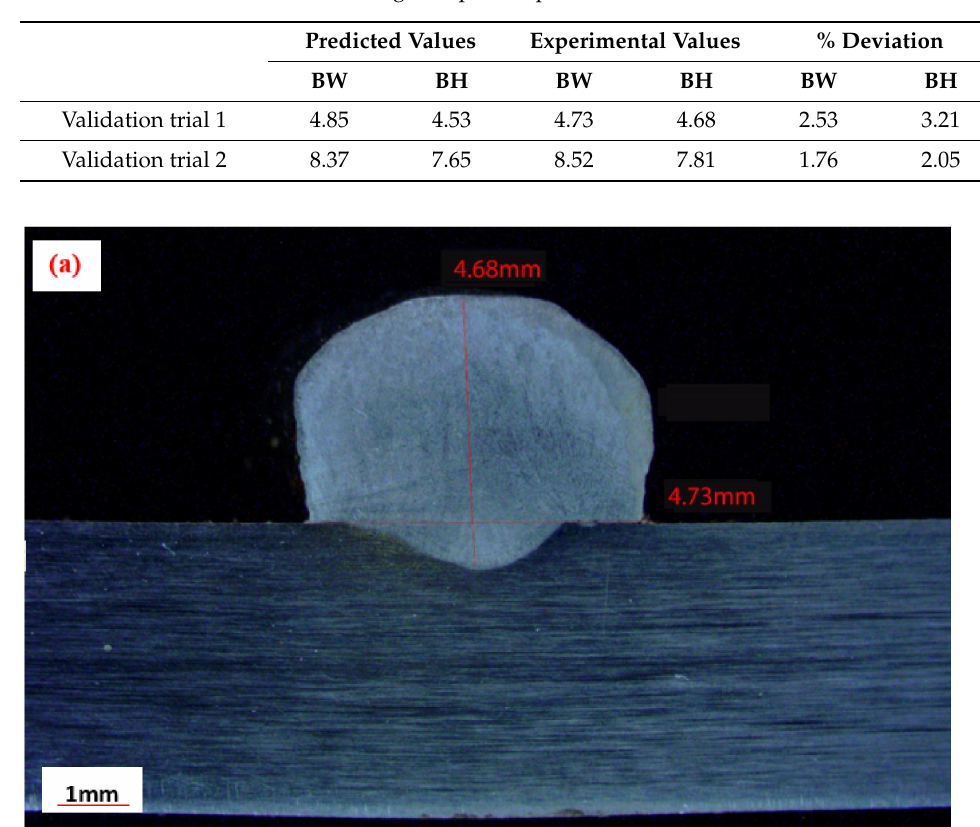
Table 6. Validation trial results for single-response optimization of BW and BH.